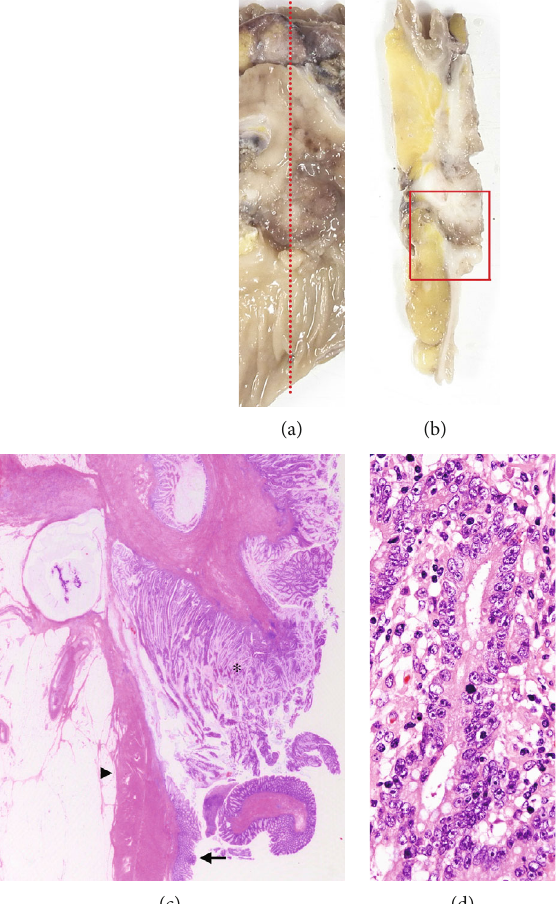
Figure 4: Microscopic fi ndings of the resected specimen. (a) The specimen was cut along a red dotted line which included the appendiceal tumor and the invaded sigmoid colon. (b) A cross-section of the cut specimen. The area surrounded by a red box was examined microscopically. (c) A microscopic view. The tumor (indicated by an asterisk) had come into contact with the inner side of the sigmoid colon. The muscularis propria and the mucosa of the sigmoid colon are indicated by an arrowhead and an arrow, respectively. (d) A higher magni fi cation view showing that the tumor was a well-di ff erentiated tubular